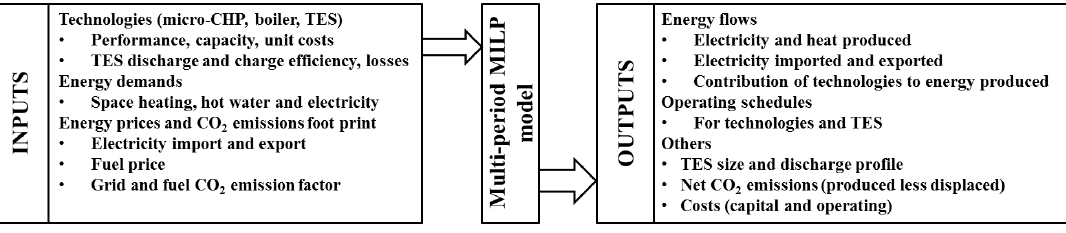
Figure 1. Model summary. CHP: Combined Heat and Power; TES: Thermal Energy Storage.